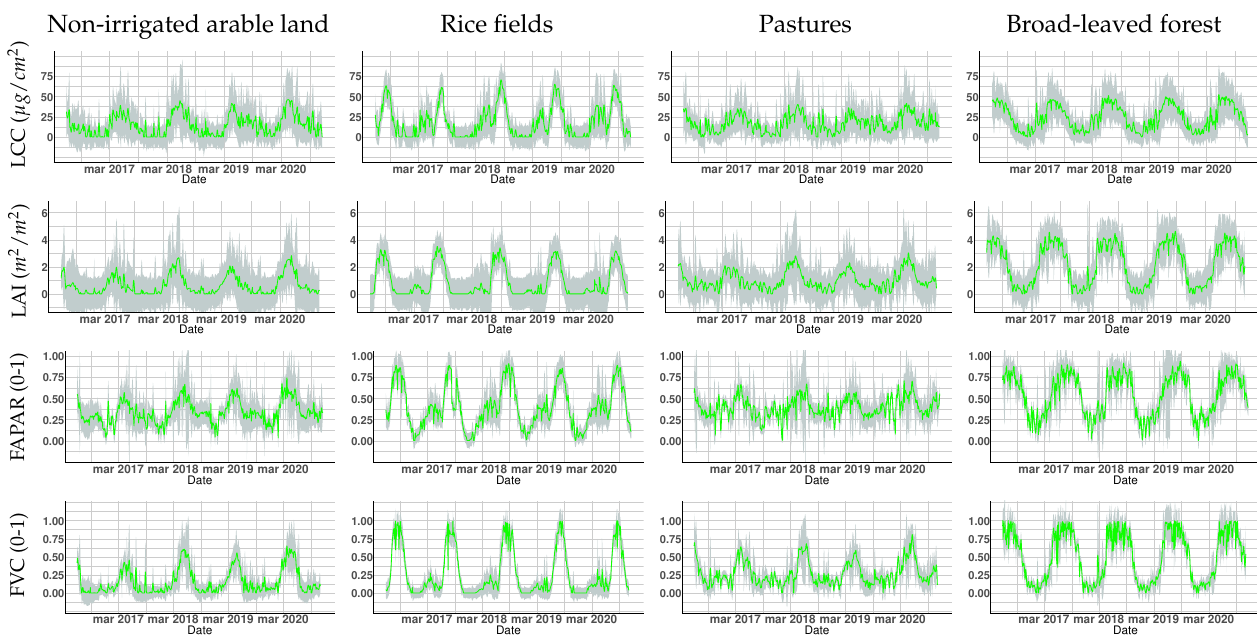
Figure 6. Time series of vegetation traits (LCC, LAI, FAPAR, FVC) over different land covers produced by the S3-TOA-GPR-1.0 models. The grey shaded colors present the uncertainty ( σ ) of the estimates (green). Original resolution of 300 m was used for spatial average calculations.